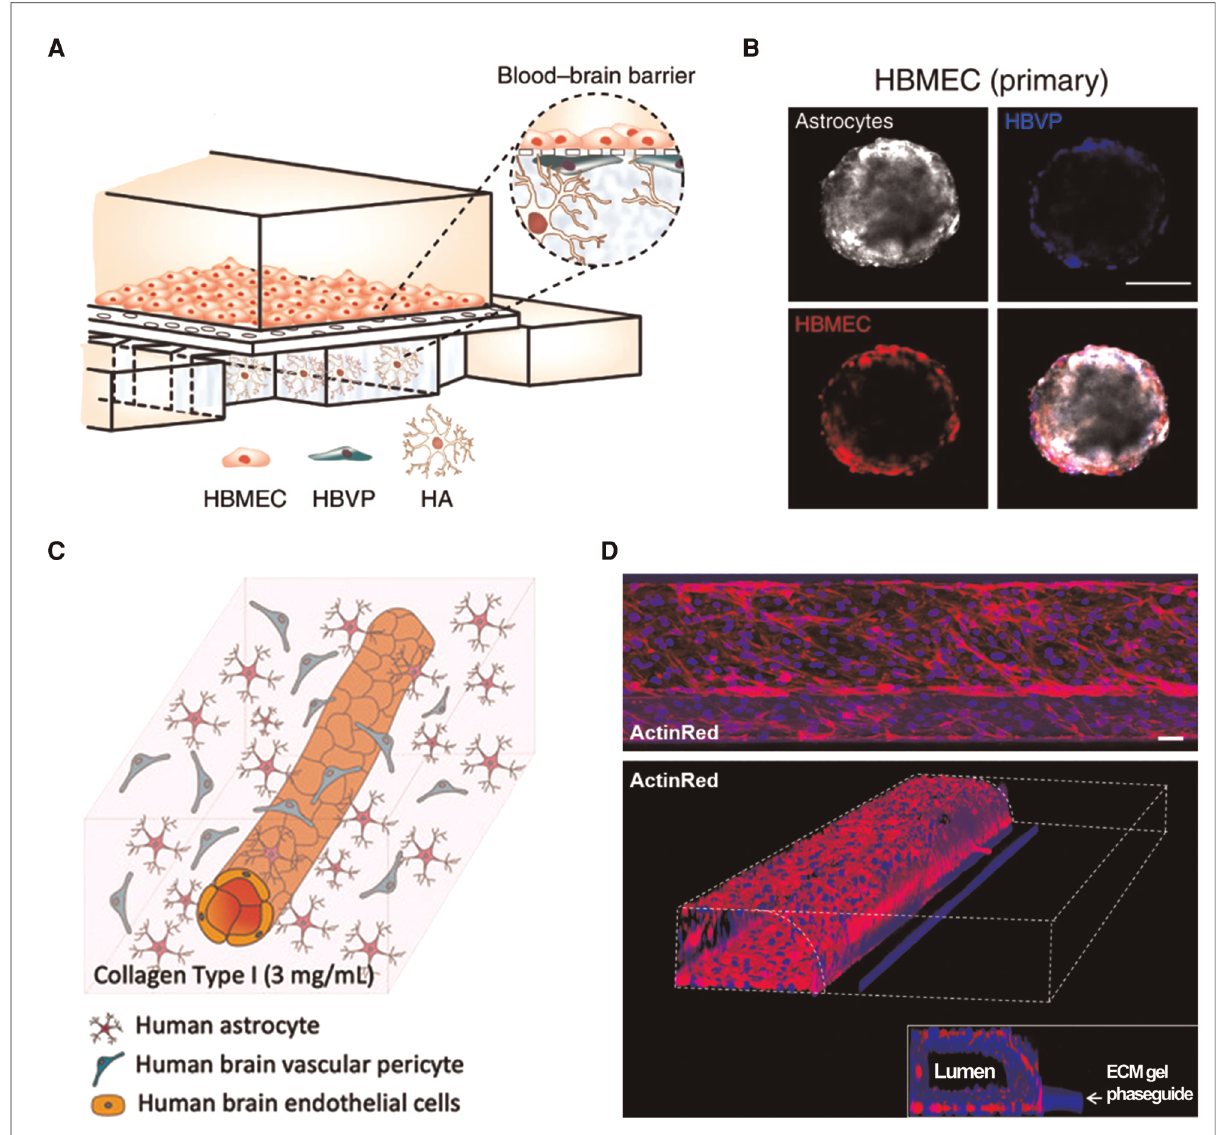
FIGURE 2 Current in vitro blood – brain barrier models. ( A ) Planar MPS based on porous membrane substrate (32). ( B ) Spheroid model (33). ( C ) Perfusable hydrogel-laden MPS (36). ( D ) Perfusable micro fl uidic model (37). All open access